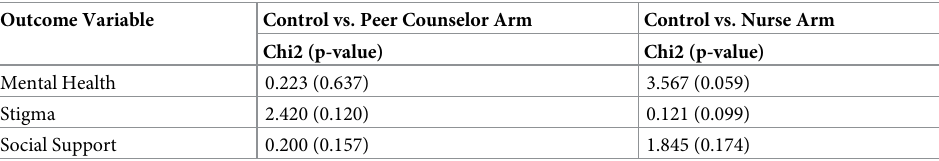
Table 3. Kruskal- Wallis one-way ANOVA test to compare effects of each study